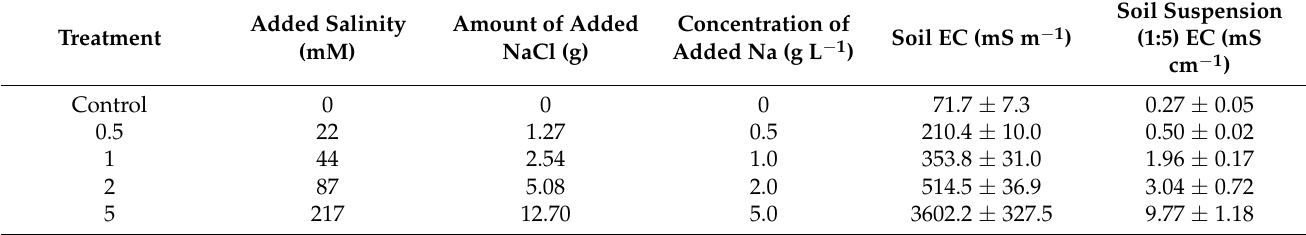
Table 3. Experimental treatments used in the present study. Soil EC (measured in containers with a sensor) and soil suspension EC were analyzed after reaching final treatment concentrations. EC, electrical conductivity.